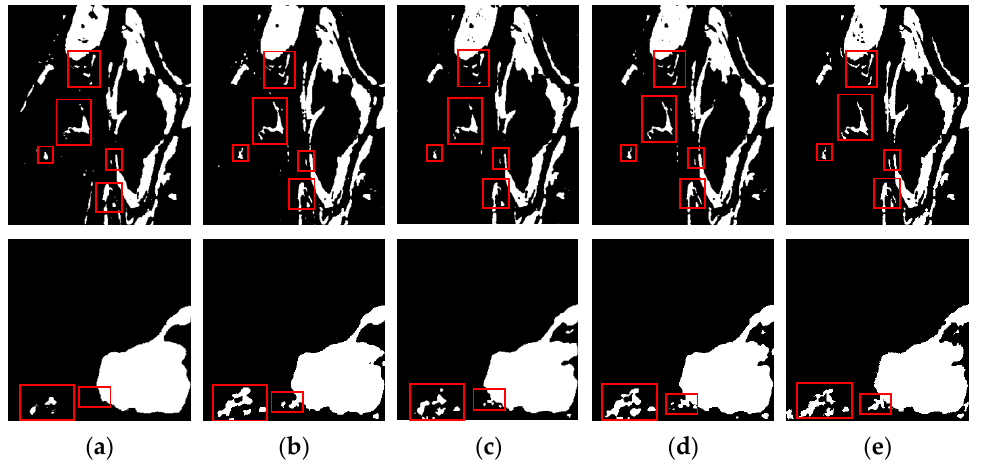
Figure 10. Comparison of CD results from networks with or without SSN in the Ottawa dataset (first row) and Sulzberger dataset (second row). ( a ) FC-Siam-diff; ( b ) SSN-Siam-diff; ( c ) FC-Siam-conc; ( d ) SSN-Siam-conc; and ( e ) ground truth. The areas marked by red boxes deserve more attention. Table 3. Quantitative results of Ottawa dataset for models with SSN or without.